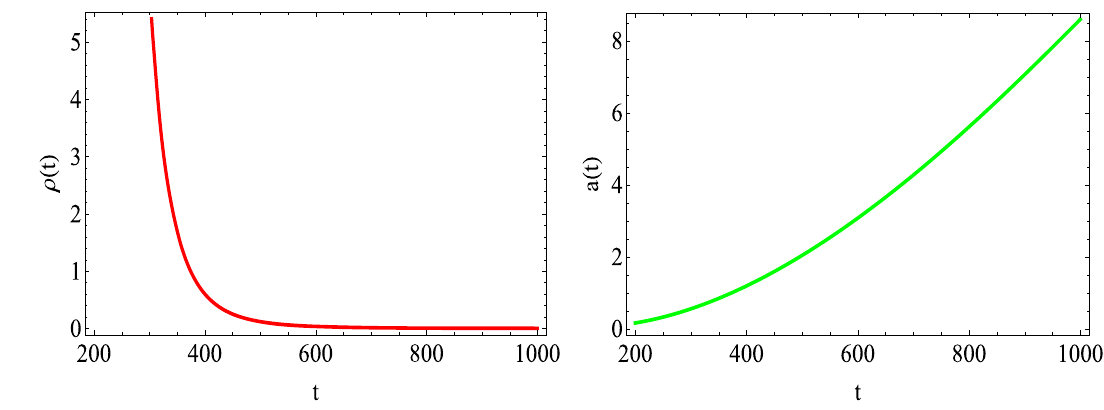
Fig. 7 The evolution of the density ρ( t ) versus the cosmic time variable t (left panel) and the scale factor a ( t ) (right